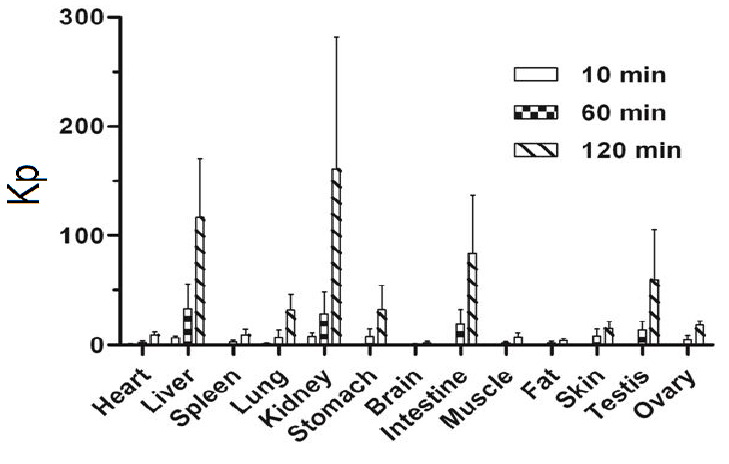
Figure 4. Ratio of tissue toplasma concentrations (Kp) at 10, 60 and 120 min after receiving a single i.v. dose of wogonin at 20 mg/kg. (mean ± SD, n = 6, except for testis/ovaries where n =